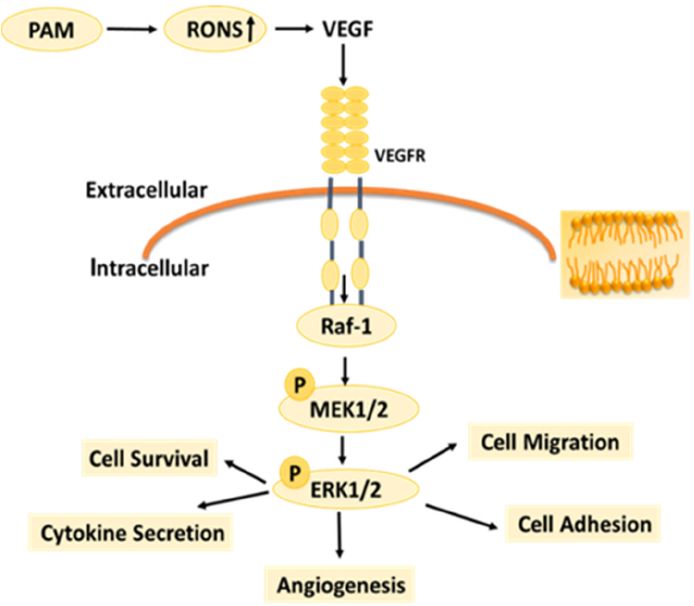
Figure 10. Possible mechanism by which PAM affects HUVECs.